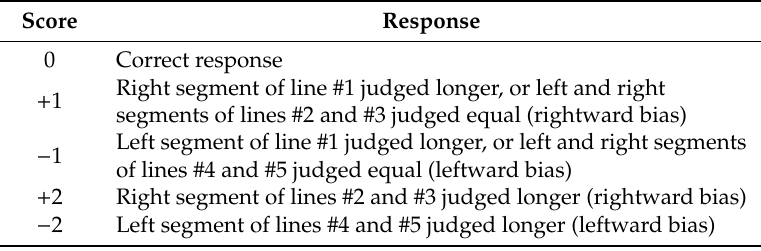
Table 1. Score and response in line length judgement